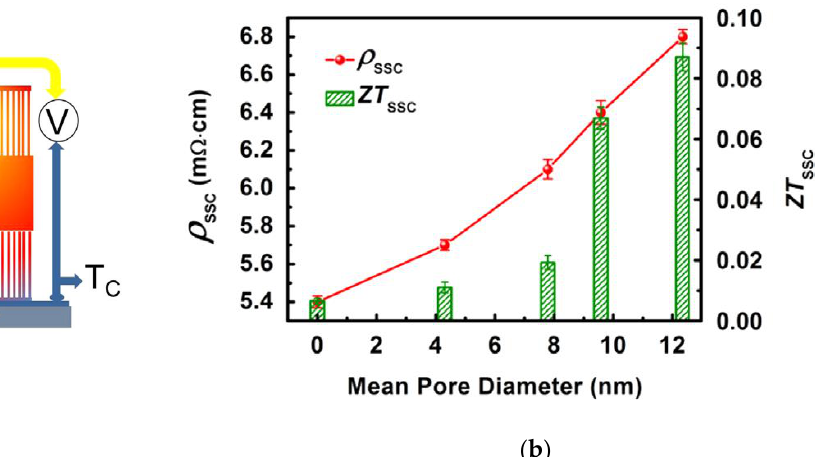
Figure 2. ( a ). Schematic representation of the modified structure of thermoelectric devices based on SiNWs. ( b ) Chart representing the effect of mean pore diameter on the electrical resistivity and ZT values of the fabricated thermoelectric devices. Reprint with permission [5283611435296]; Copyright Year 2022, Elsevier Publisher [18].